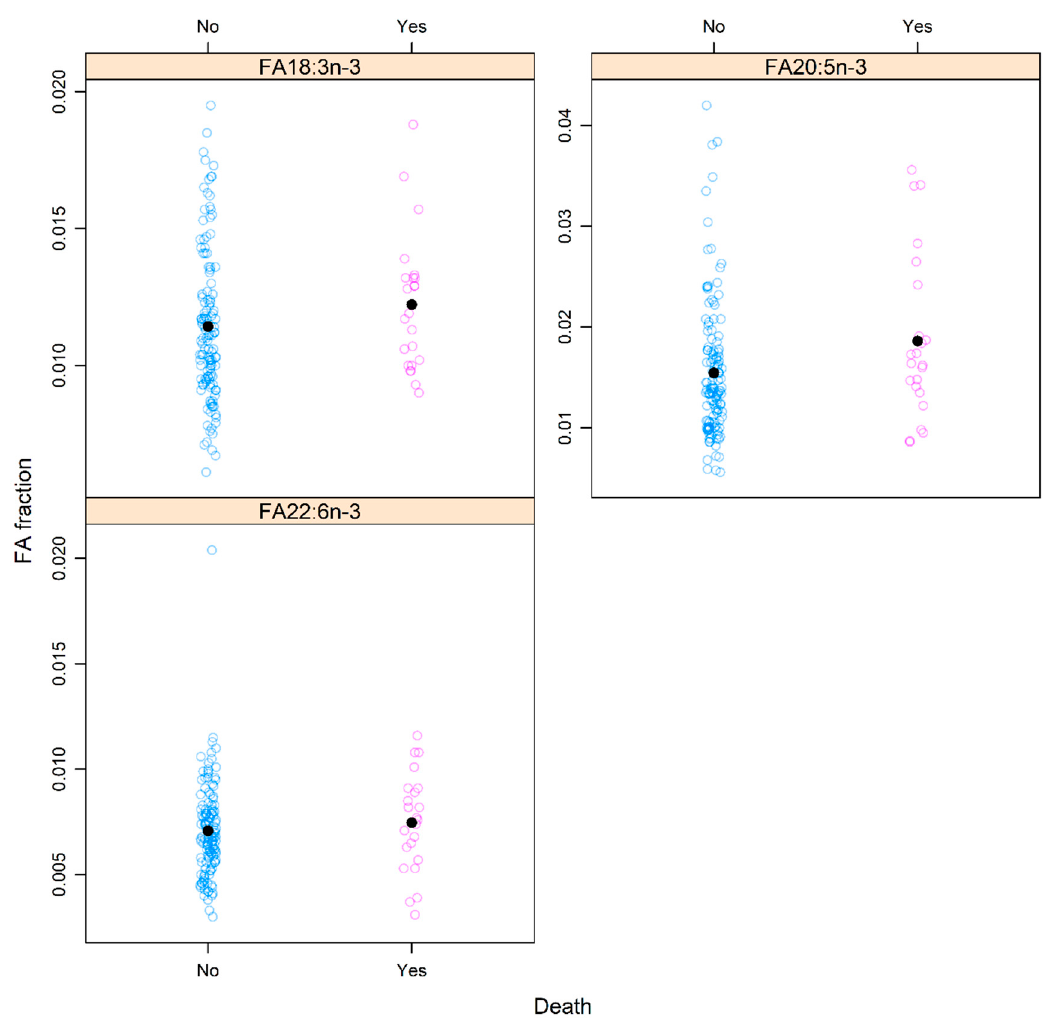
Figure 7. Association between all-cause death (yes = death, no = alive) and levels of fatty acids (FAs) 18:3n-3, 20:5n-3, and 22:6n-3 at 3 months after the end of